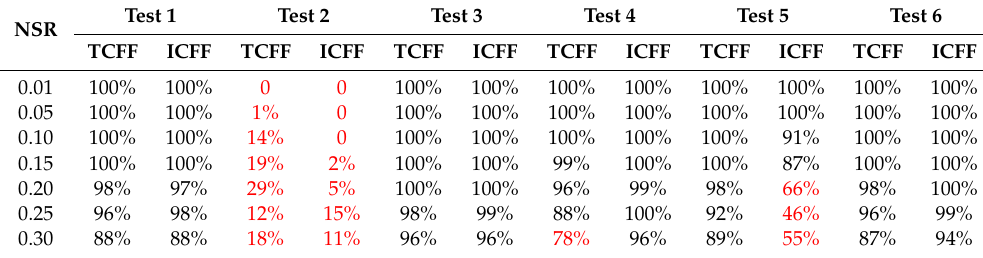
Table 3. Percentage of correct EO identification following the noise-to-signal ratio (NSR) values.